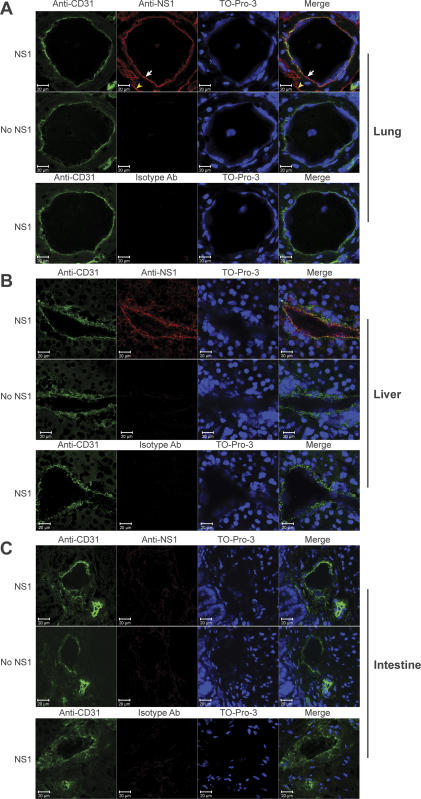
Binding of DENV NS1 to Mouse TissuesCryo-sections of mouse (A) lung, (B) liver, and (C) intestine were incubated with serum-free supernatants from BHK DENV-2 Rep or BHK cells for 1 h at room temperature. After extensive washing, bound NS1 was detected by a mixture of NS1 mAbs (1A4, 1F11, 2G6, 1B2) followed by Cy3-conjugated goat anti-mouse IgG. Co-staining with endothelial cell marker was subsequently performed by incubating the sections with rat anti-mouse CD31 (PECAM-1) followed by Alexa Fluor 488-conjugated goat anti-rat IgG. Nuclei were stained with a DNA-specific dye TO-PRO-3. Sections incubated with DENV NS1 followed by an isotype control Ab served as a negative control. Analysis was performed by confocal microscopy. White arrow and yellow arrowhead denote the layer of endothelial cells in the lumen and the outer layer of the adventitia of pulmonary vessel, respectively.